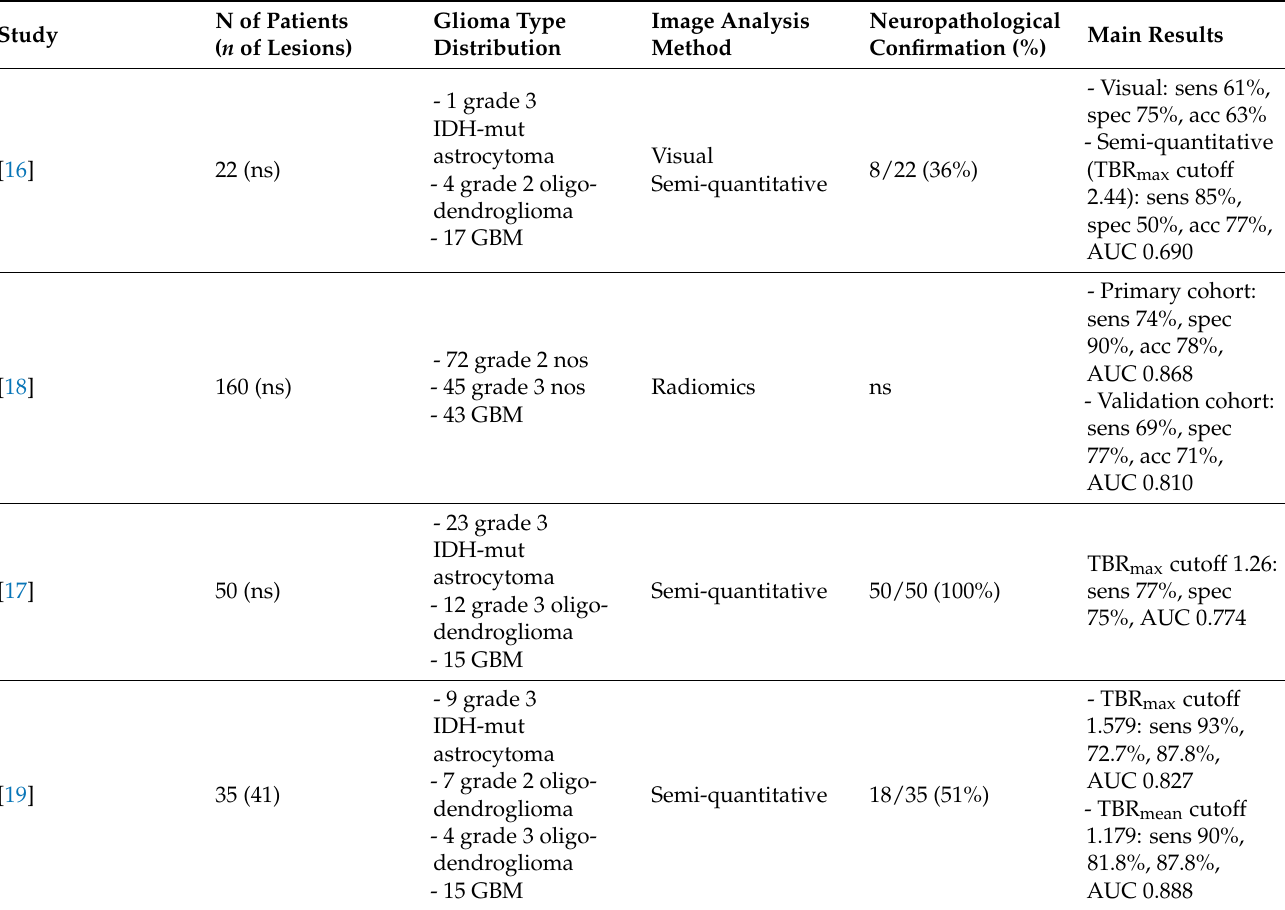
Table 2. Summary of studies investigating the diagnostic accuracy of [ 18 F]FDG